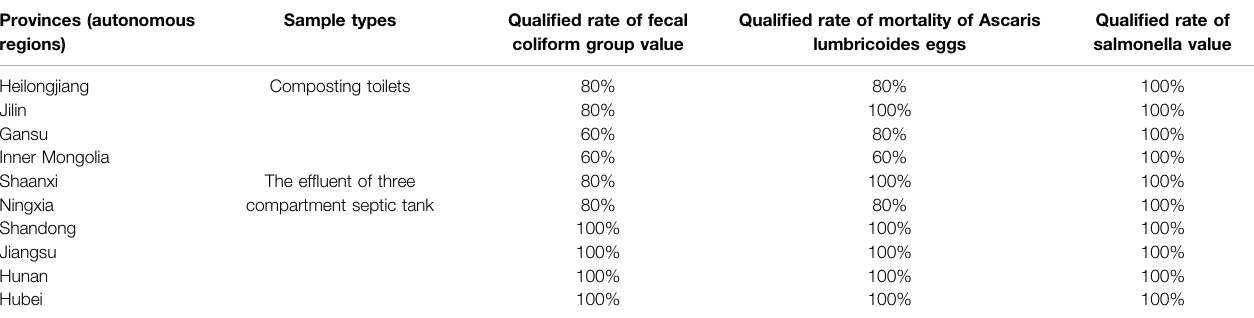
TABLE 1 | The quali fi ed rate of harmless treatment of feces after toilet modi fi cation. Provinces (autonomous regions)